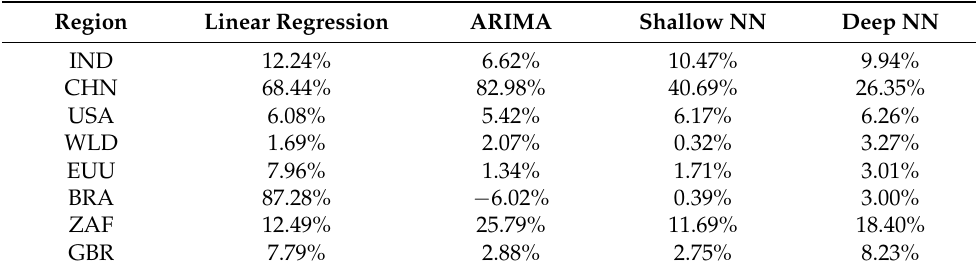
Table 5. Difference between the mean average percentage error on the test set and on the training set (MAPE on the test set minus the MAPE on the training set) for different regions and different models, and under a polynomial degree of three.